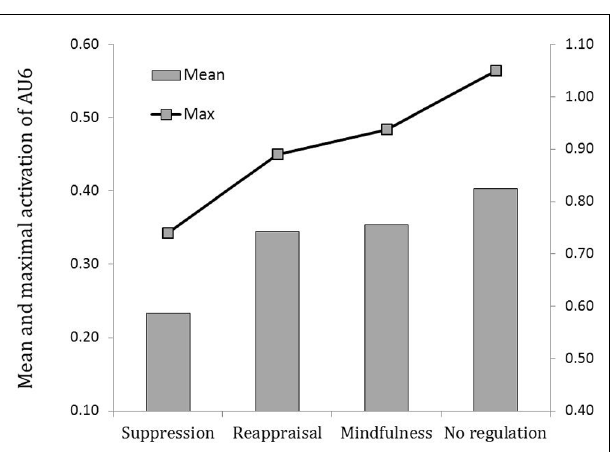
FIGURE 3 |Average and maximal activation ofAU6 (cheek raiser) depending on the regulation strategy condition. Left ordinate axis refers to average activation and right ordinate axis refers to maximum